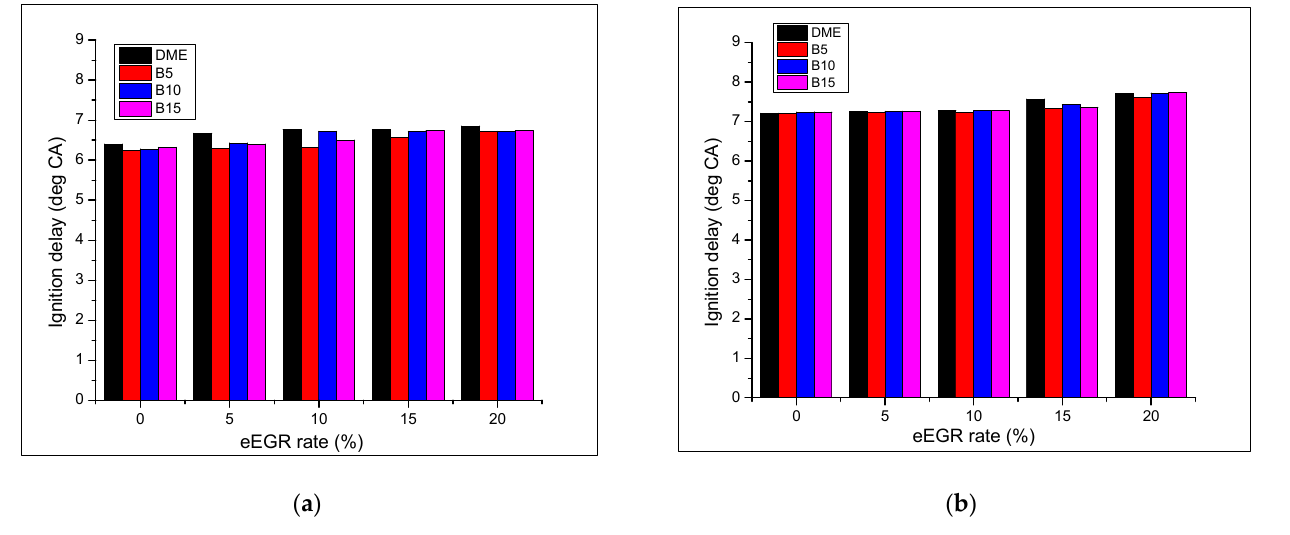
Figure 4. Effect of eEGR rate on ignition delay at: ( a ) low load (BMEP = 0.4 MPa); ( b ) high load (BMEP = 0.8 MPa).